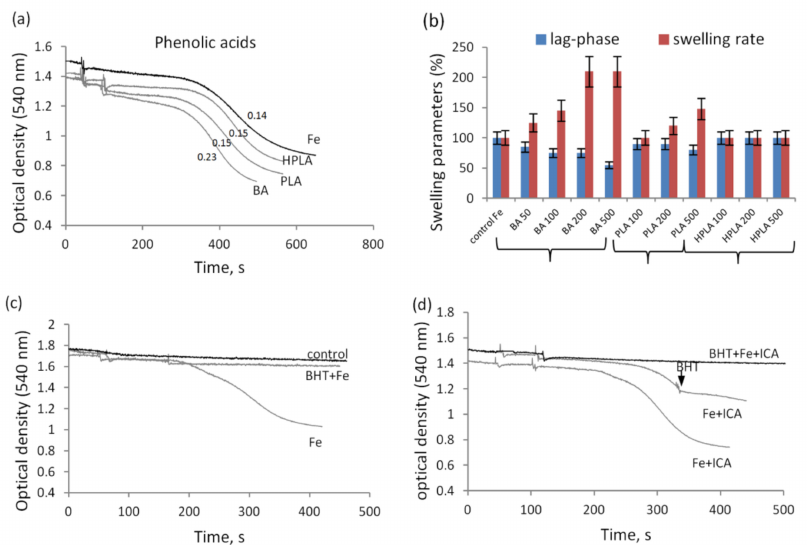
Figure 3. Influence of phenolic acids on mitochondrial swelling induced by iron ions and its elimina- tion by BHT. Activation of the swelling of mitochondria during incubation with iron ions (50 µ M FeSO 4 ) and phenolic acids at a concentration of 100 µ M ( a ); changes in the swelling parameters in the presence of 50 µ M FeSO 4 and phenolic acids in the concentration range 100–500 µ M ( b ); and the elimination by BHT of swelling induced by 50 µ M FeSO 4 alone ( c ) and with 100 µ M ICA ( d ).